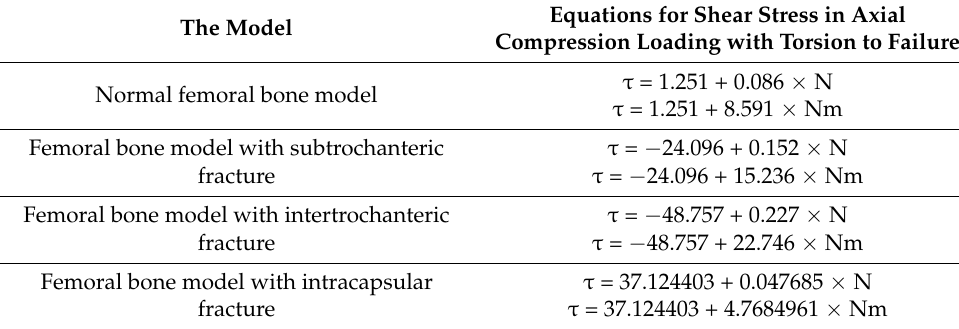
Table 9. Equations for shear stress in axial compression loading with torsion to failure.